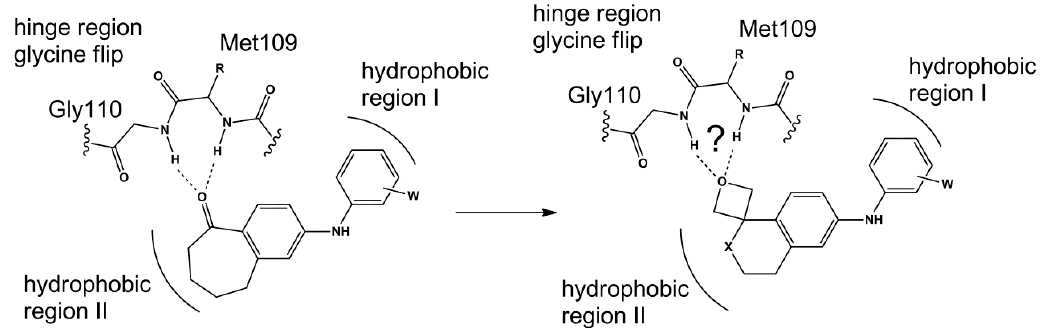
Figure 1. Natural products and marketed drugs containing an oxetane group.